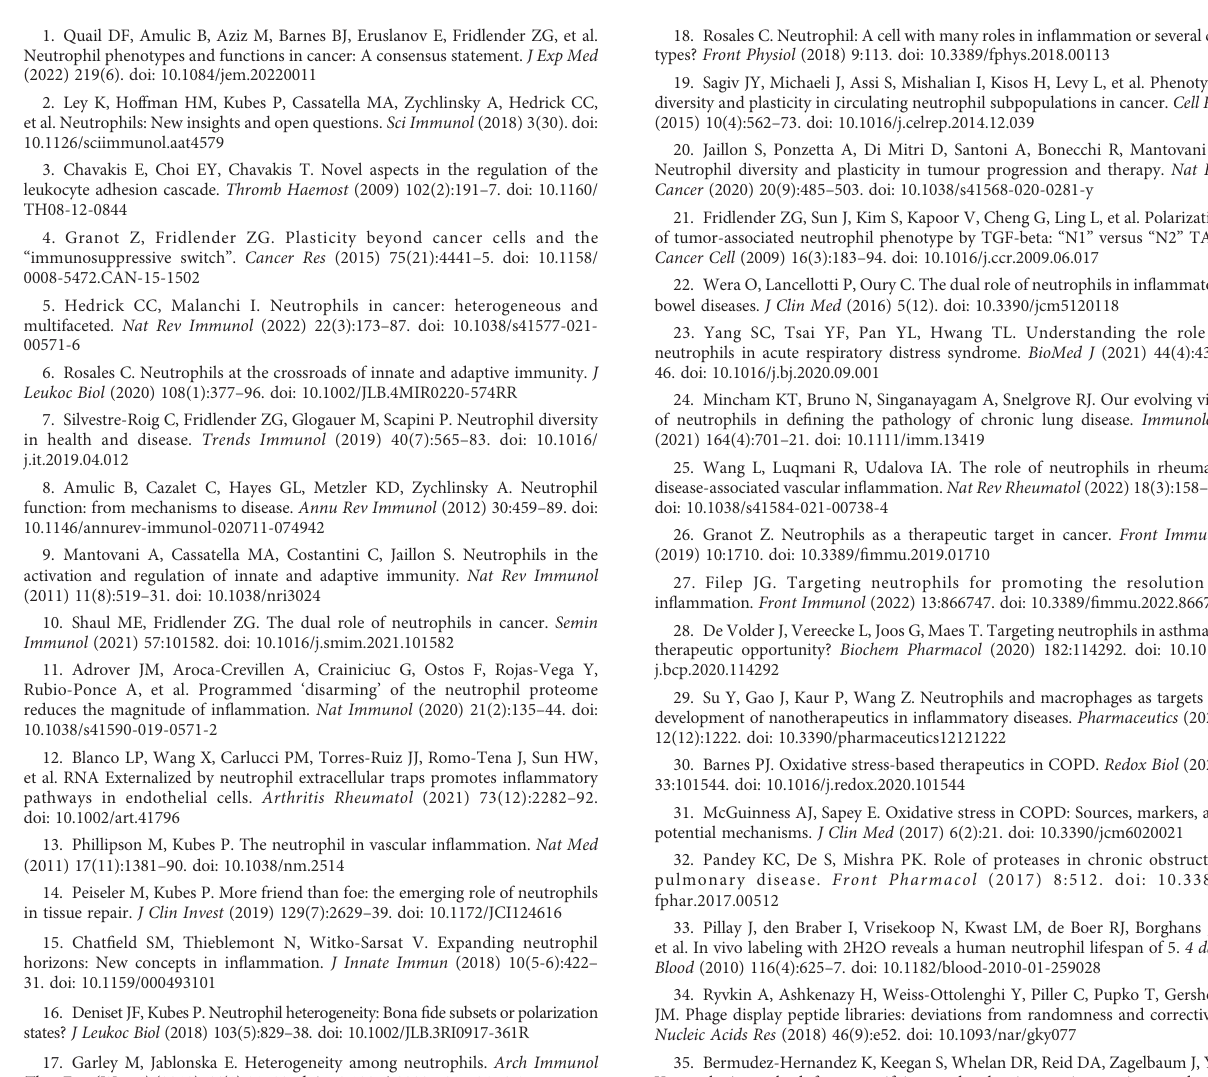
SUPPLEMENTARY TABLE 1 Characteristics of human blood